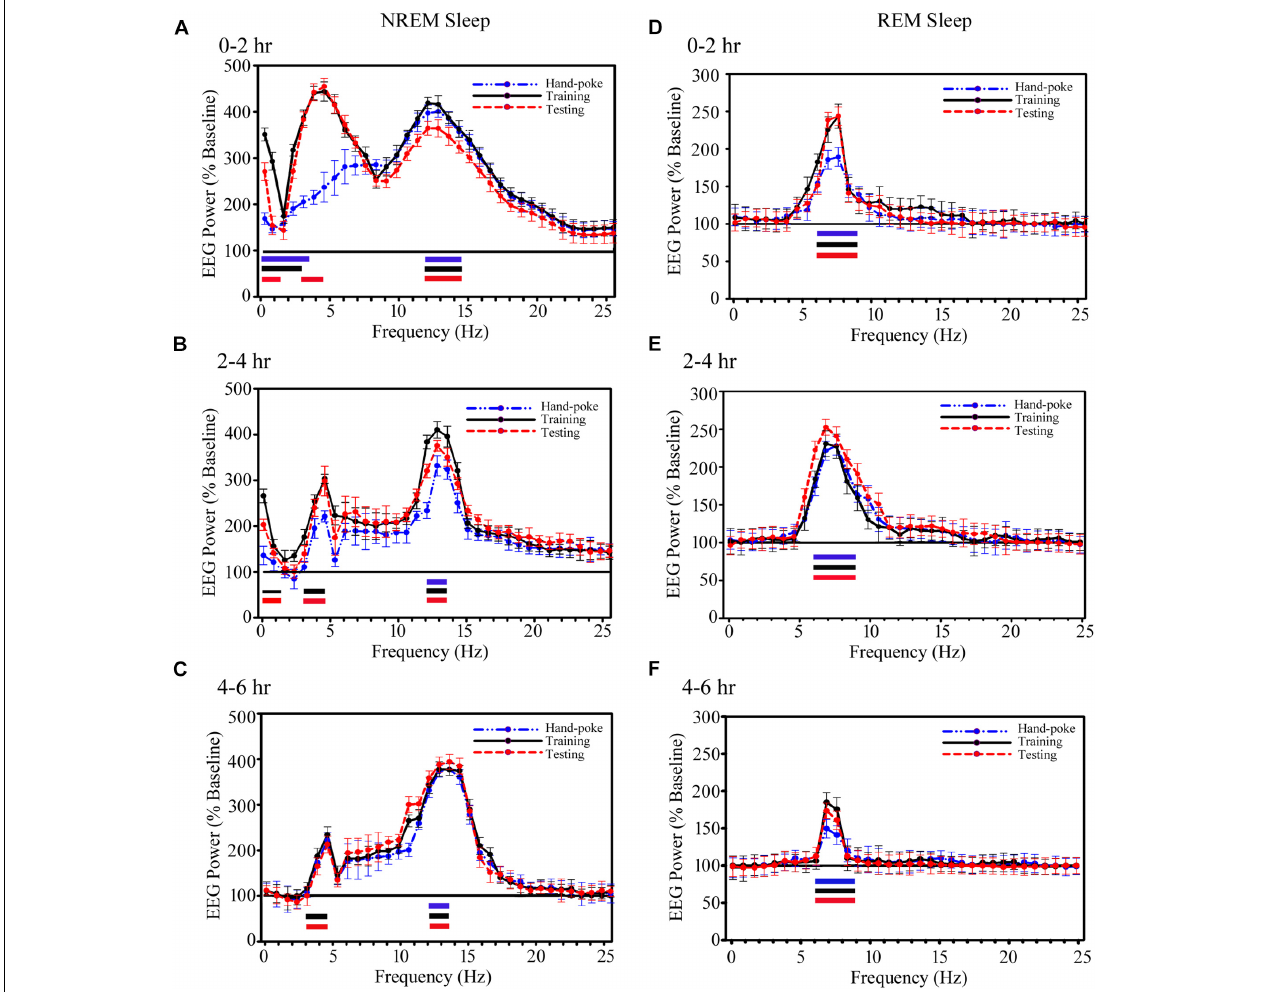
FIGURE 5 | The cortical EEG’s SWA and sigma waves (spindles) recorded from the parietal cortices during NREM sleep and theta waves during REM sleep significantly increased on the training and testing days. (A) During NREM sleep, SWA significantly increased in 0.1–3.75 Hz range on the hand-poke training day, 0.1–3.0 Hz range on the training and 0.1–1.5 Hz range and in 3–4.5 Hz range on the testing days during the 0–2 h period. EEG power in sigma range (12–14.25 Hz) during NREM sleep also significantly increased on the hand-poke training, appetitive-conditioned training and testing days during 0–2 h compared to the baseline day. (B) SWA significantly increased in 0.1–1.5 Hz and 3–4.5 Hz range during 2–4 h after appetitive-conditioned training and testing. Sigma waves also remained significantly augmented in 12–13.5 Hz during 2–4 h after hand-poke training and appetitive conditioned training and testing. (C) Interestingly, SWA remained significantly increased in the high-frequency range (3.0–4.5 Hz) during 4–6 h after appetitive conditioned training and testing. The power of EEGs sigma waves remained consistently augmented in 12–13.5 Hz frequency range during the 4–6 h period after hand-poke training and appetitive-conditioned training and testing. Theta wave (6–9 Hz) during REM sleep remained significantly increased during (D) 0–2 h period, (E) 2–4 h period, and (F) 4–6 h period after hand-poke training and appetitive-conditioned training and testing. Three different colored bars above abscissa: Blue colored bar ( ) represents significant changes on hand-poke training; black colored bar ( ) represents significant changes on appetitive-conditioned training, and red colored bar ( ) represents significant changes on the appetitive-conditioned testing day compared to the baseline day. The thickness of the colored bars above abscissa: Thick bar ( ) represents Bonferroni corrected p < 0.001; thin bar ( ) represents Bonferroni corrected p <